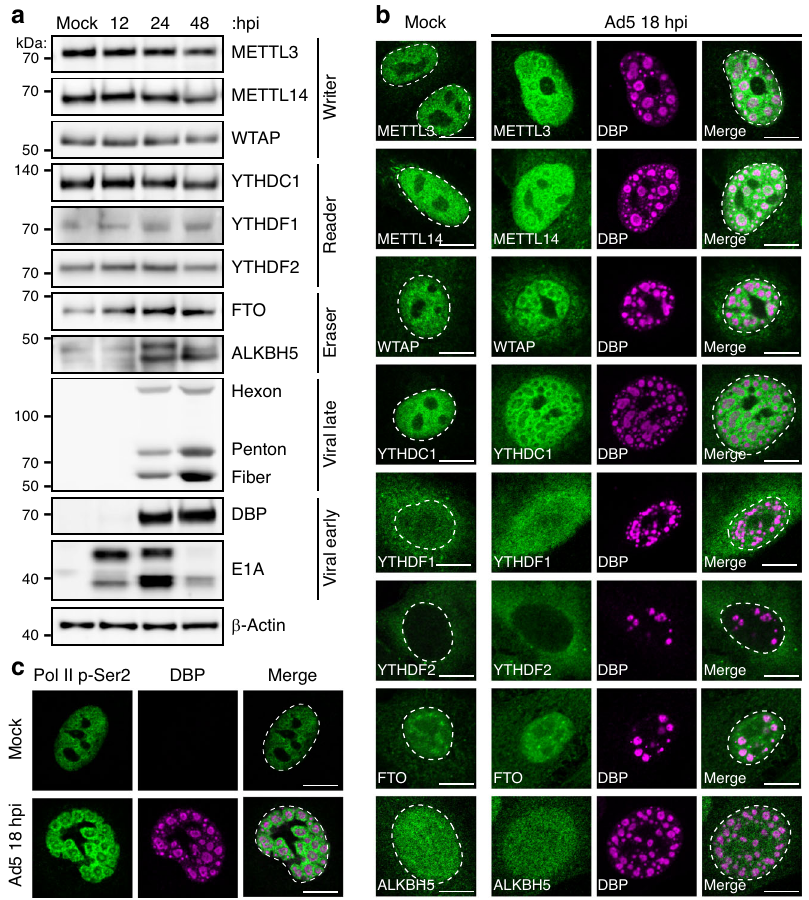
Fig. 1 Nuclear m 6 A-interacting factors concentrate at sites of nascent viral RNA synthesis. a Abundance of cellular m 6 A proteins is unchanged during infection. Immunoblot showing abundance of m 6 A writers, readers, and putative erasers over a time-course of adenovirus infection. Viral early (E1A and DBP) and late (Hexon, Penton, and Fiber) proteins demonstrate representative kinetic classes. β -Actin is the loading control. Kilodalton size markers shown on the left. b Confocal microscopy of m 6 A-interacting proteins (green) in mock-infected or Ad5-infected A549 cells 18 h post-infection (hpi). DBP (magenta) is the viral DNA binding protein that marks sites of nuclear viral replication centers. The nuclear periphery is shown by a dotted white line as assessed by DAPI staining. Scale bar = 10 µ m. c Confocal microscopy showing the pattern of actively transcribing RNA Polymerase II phosphorylated on serine 2 of CTD (Pol II p-Ser2, green) in mock-infected cells or relative to DBP (magenta) in infected cells. Scale bar = 10 µ m. All data are representative of at least three independent